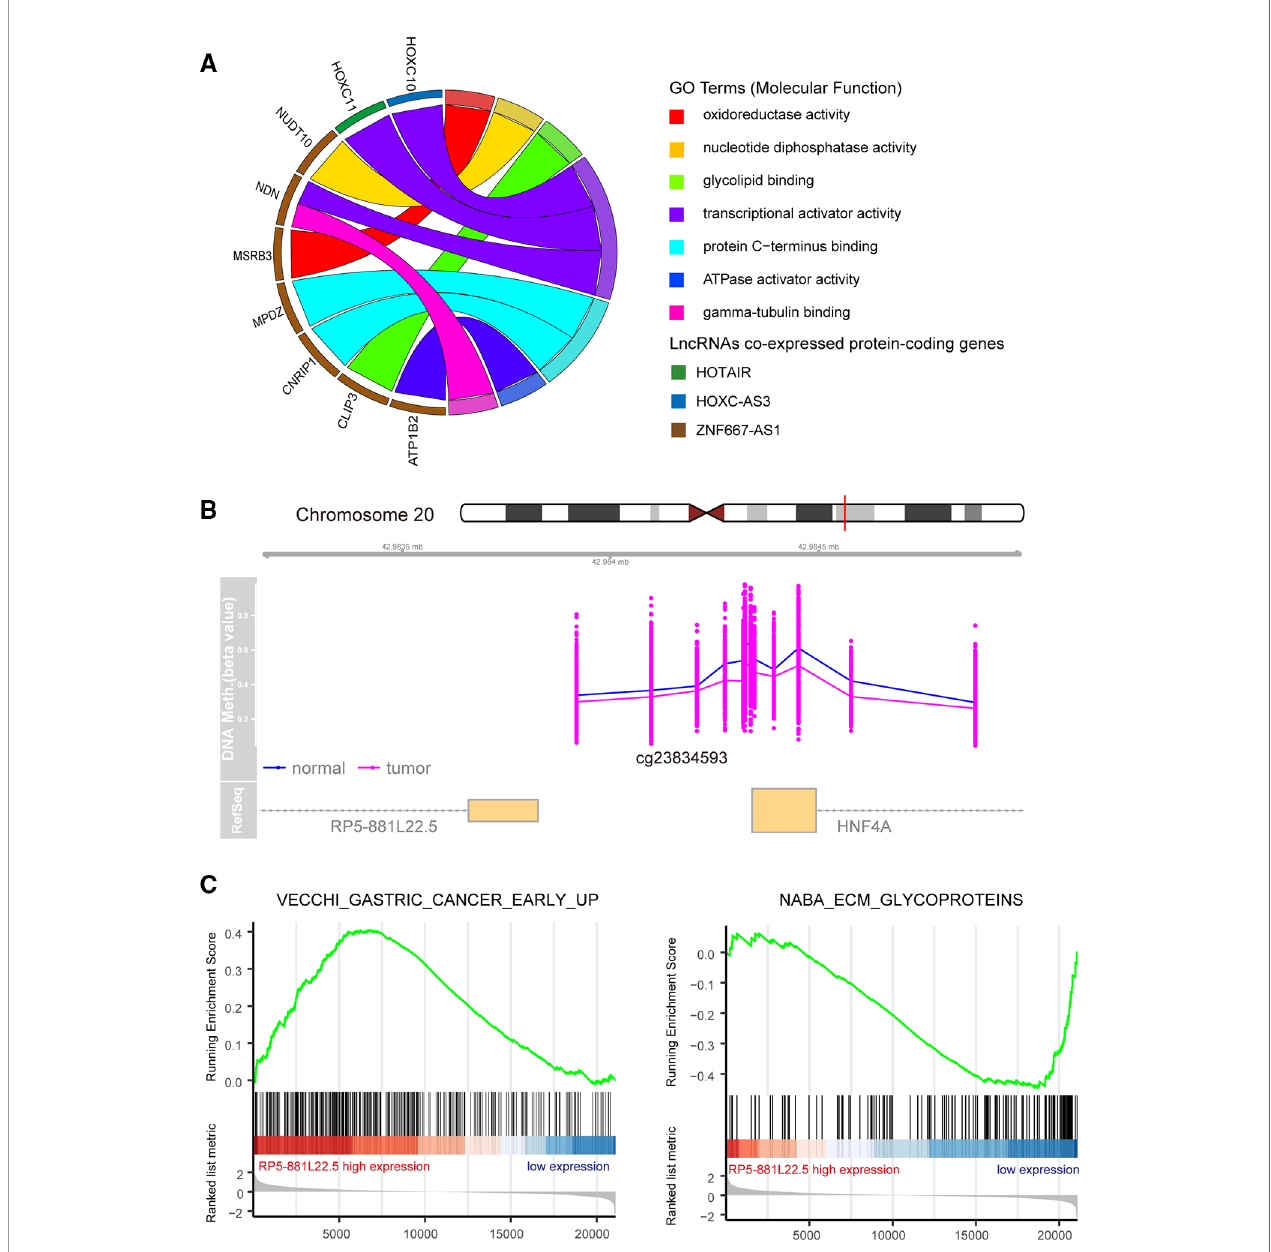
FIGURE 5 | Functional annotation for differentially methylated differentially expressed long noncoding RNAs (DElncs). (A) Circular plot of molecular function regulator Gene Ontology Term. (B) RP5-881L22.5 promoter hypermethylation in gastric cancer (GC) tumors compared with normal tissues. (C) Gene set enrichment analysis of RP5-881L22.5 in the The Cancer Genome Atlas (TCGA)